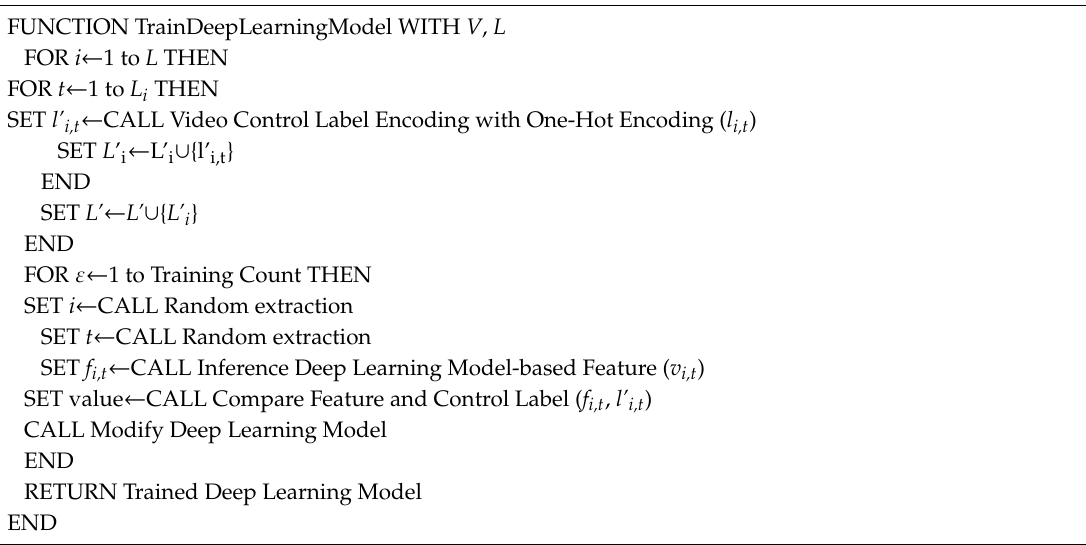
Algorithm 2 Pseudocode for training deep learning model using preprocessed 360-degree video control data FUNCTION TrainDeepLearningModel WITH V , L